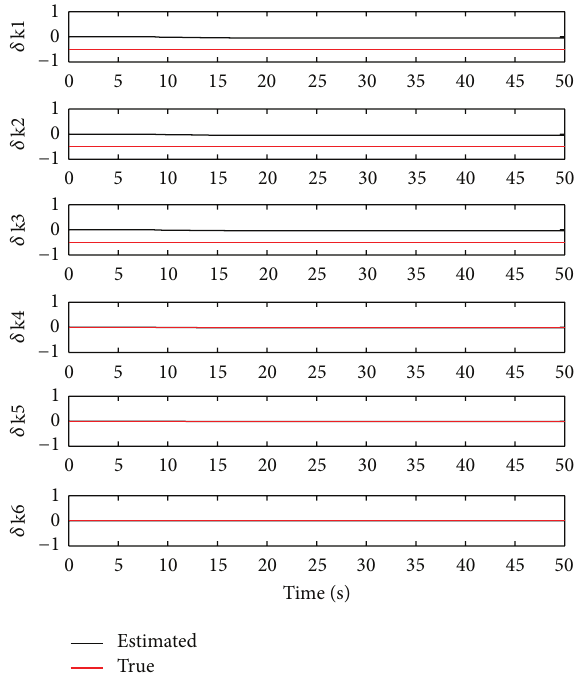
Figure 4: Damage stiffness estimation using the OTSKE with 𝑄 𝑑 𝑘 = 0.001𝐼 6